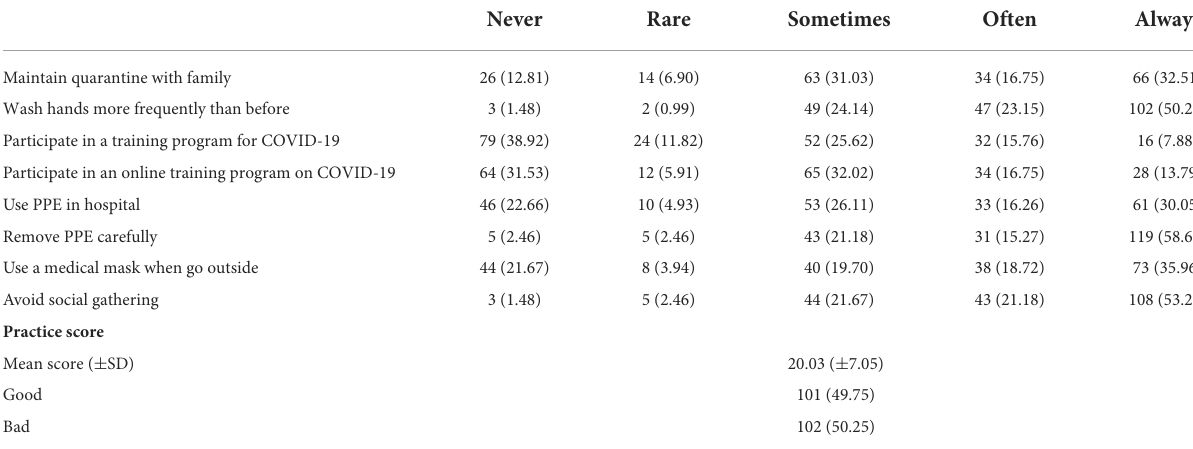
TABLE 4 Behavioral practice assessment of healthcare professionals during